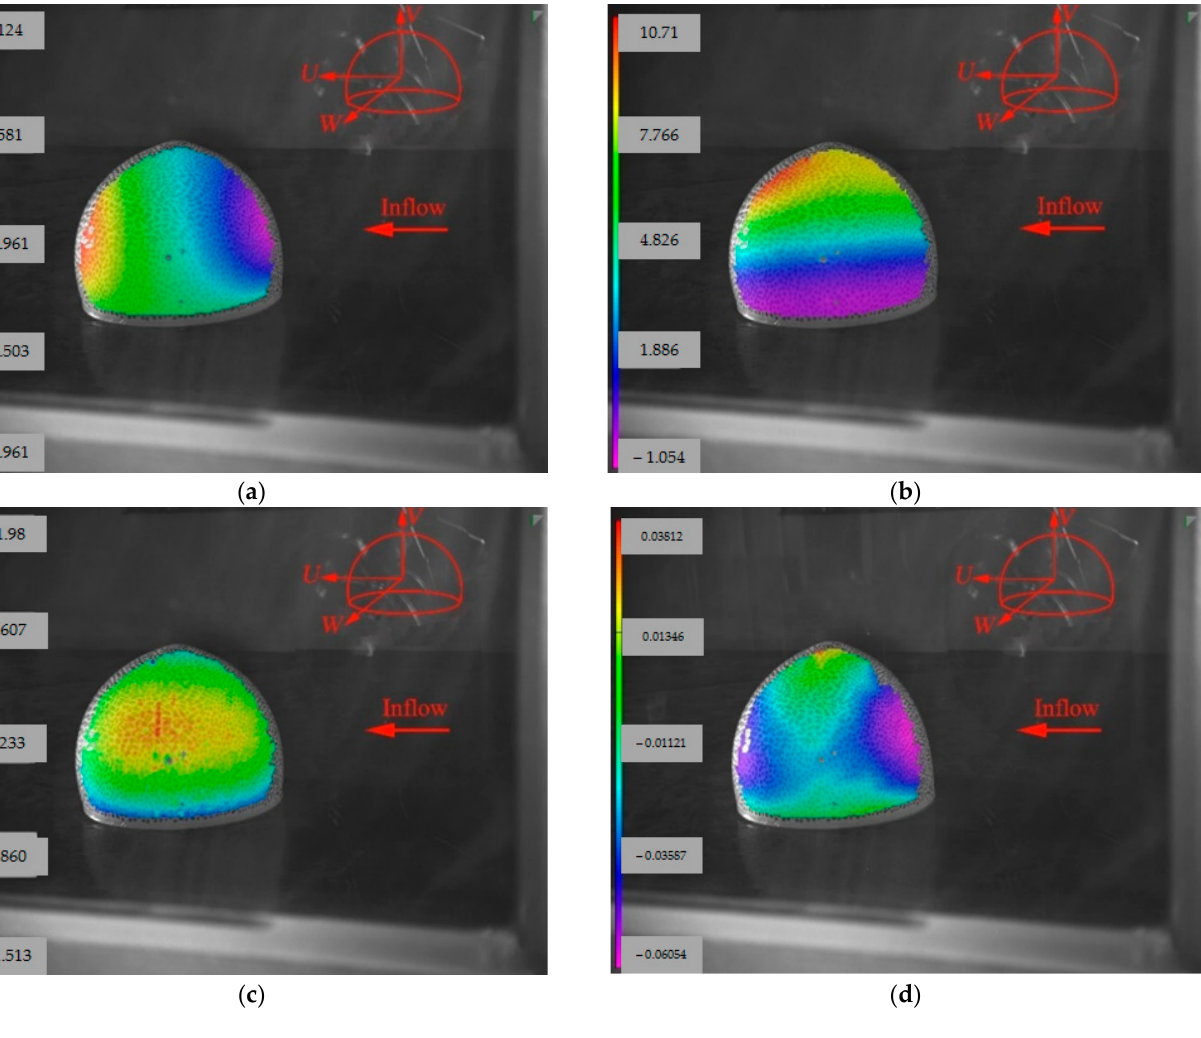
Figure 6. Transient distribution contours of displacements and maximum principal strain: ( a ) displacement of U direction at u = 4 m/s, ( b ) displacement of V direction at u = 4 m/s, ( c ) displacement of W direction at u = 4 m/s, and ( d ) maximum principal strain at u = 11 m/s.